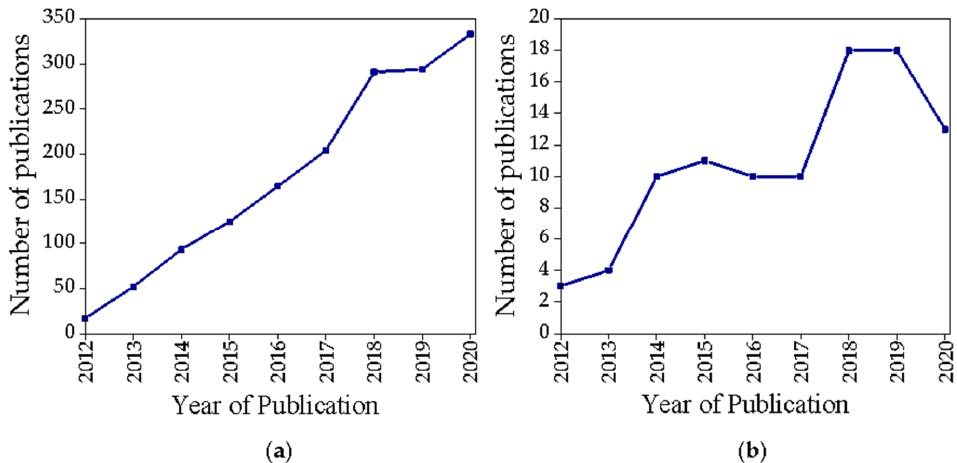
Figure 2. Scopus publication search results for the terms ( a ) “graphene + magnetic + theranostic” (all fields), ( b ) “graphene + magnetic + theranostic” (title/abstract/keywords).